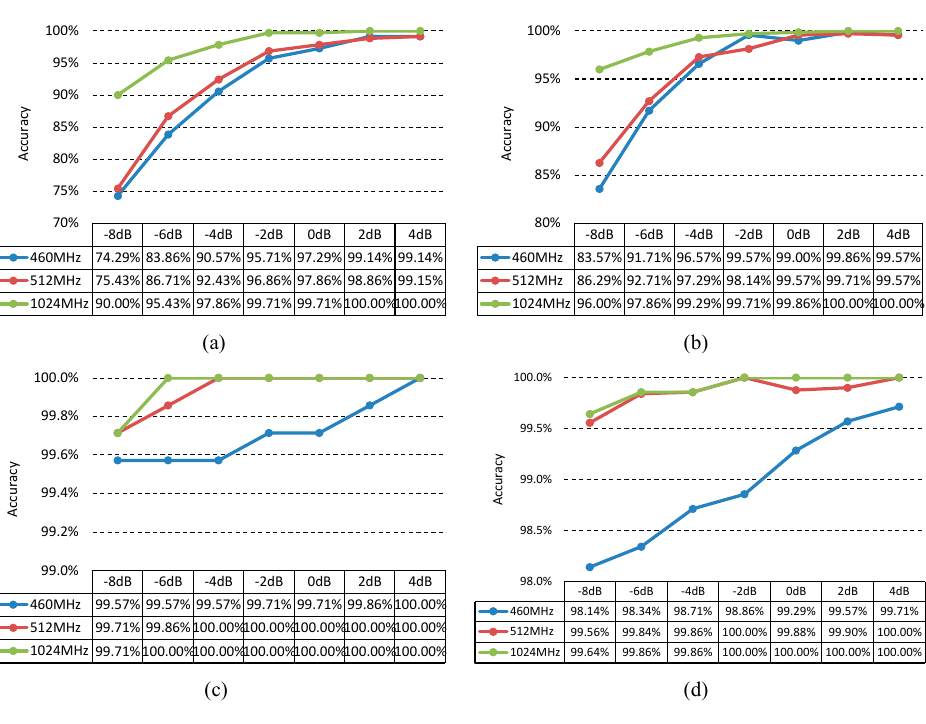
Figure 9. Average recognition rate with different sampling frequencies under ( a ) Gaussian noise, ( b ) Laplacian noise, ( c ) Poisson noise, and ( d ) Cauchy noise.